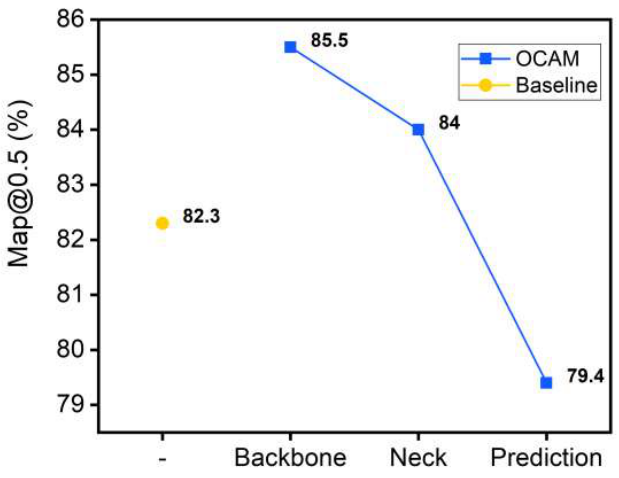
Figure 7. Network accuracy when designing the same OCAM layer in different layers. Backbone layer. By setting the attention layer in Backbone with different depths (indicated